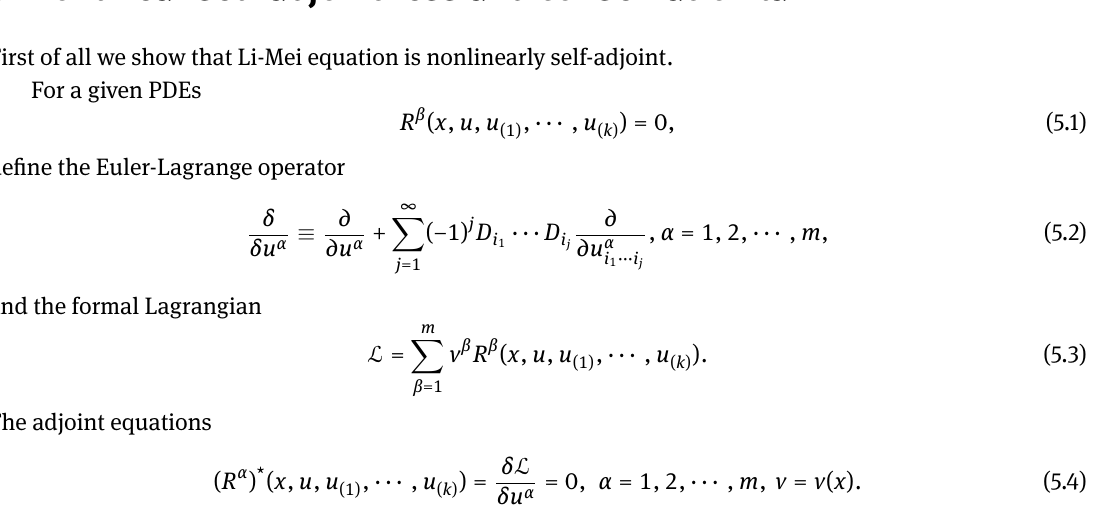
In the above, we sketch the graphs of f ( ζ ) in Eqs. (4.2), (4.4), (4.6), (4.8) and 3D-plot of u ( x , t ) in Eqs. (4.3), (4.4) under the initial conditions f (0) = 3 , f (1) = 1, f (cid:48) (0) = 2